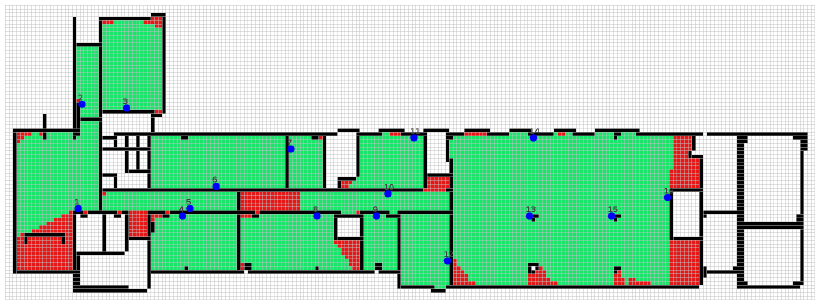
Figure 5. WSN deployment on the first floor of the Cork Institute of Technology (CIT-1).